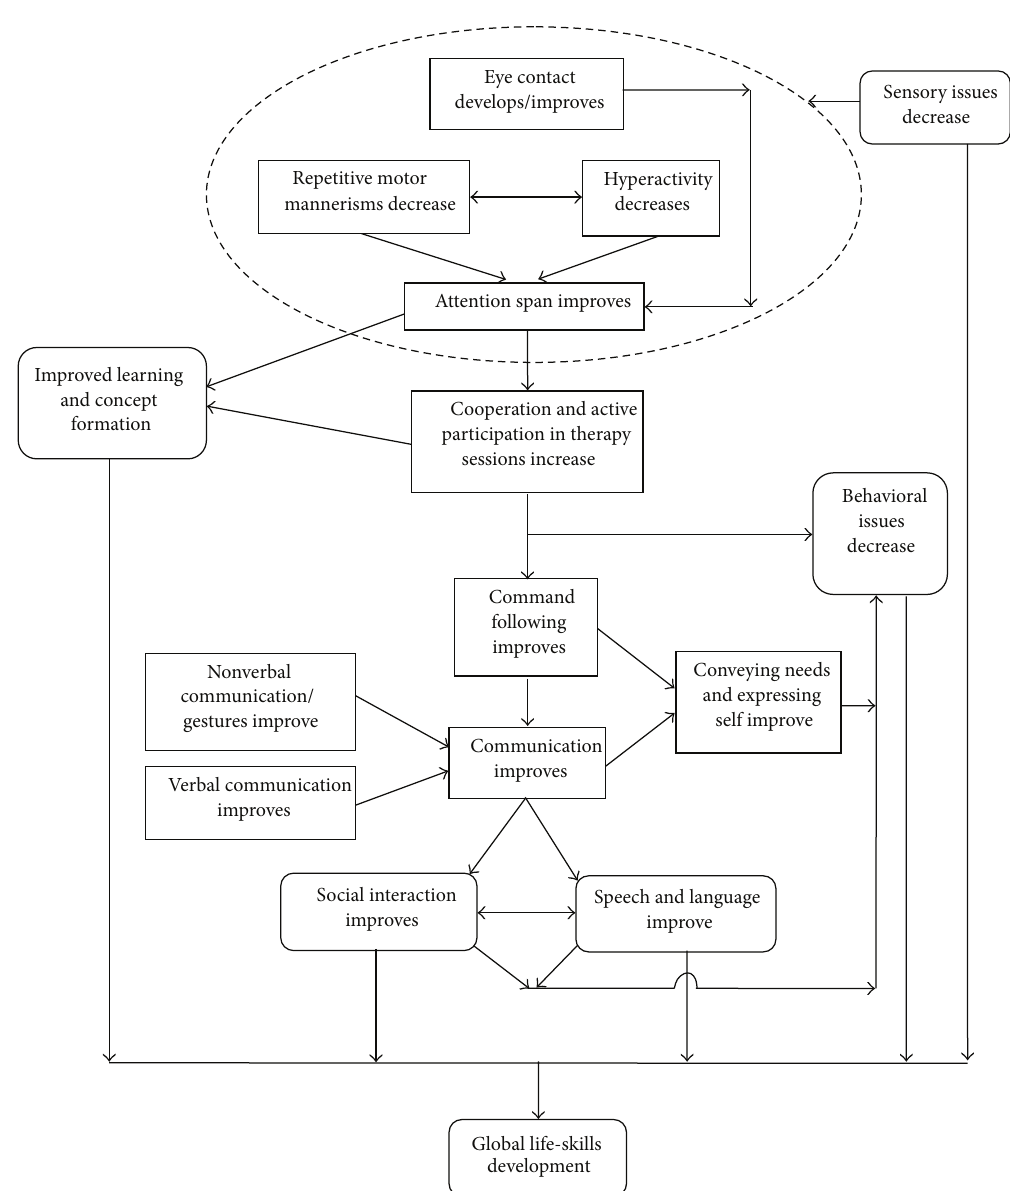
Figure 3: Schematic representation of clinical improvements after cellular therapy. This figure shows proposed theoretical outline of observed changes after cellular